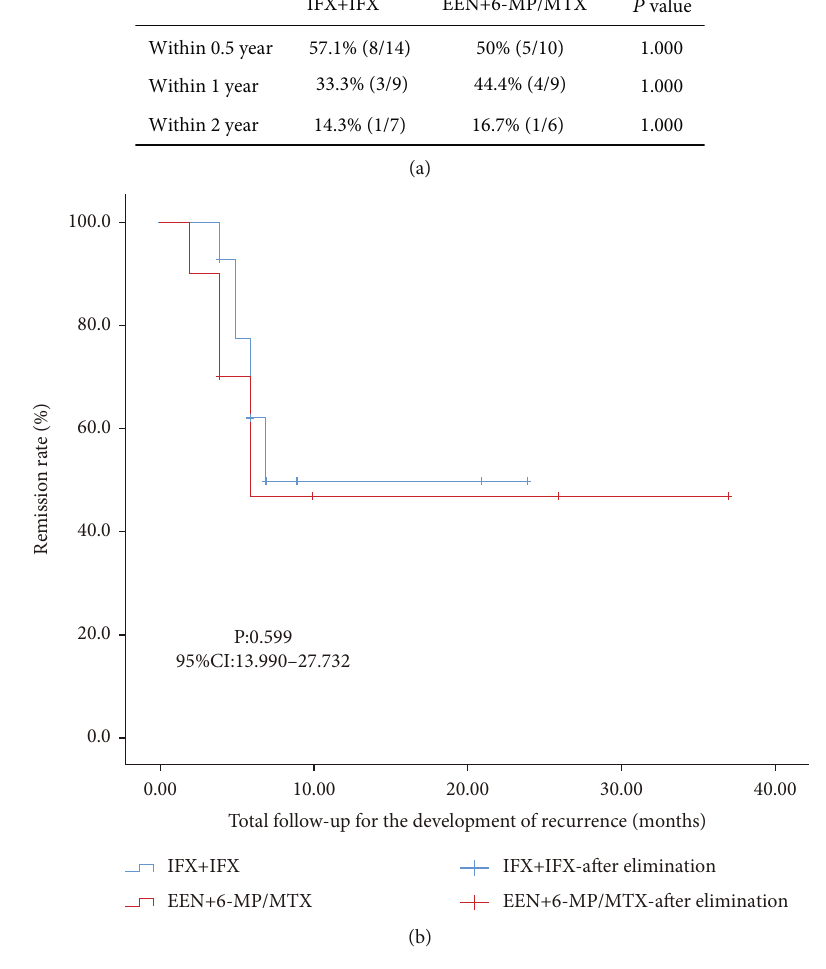
Figure 3: Comparison of sustained remission e ff ect in each treatment group. (a) Sustained remission rate at 0.5, 1, and 2 years after induction therapy between IFX+IFX and EEN+6-MP/MTX groups. (b) Kaplan – Meier curve showing sustained remission time from maintenance treatment to fi rst recurrence. The log-rank test was used to compare di ff erences among the